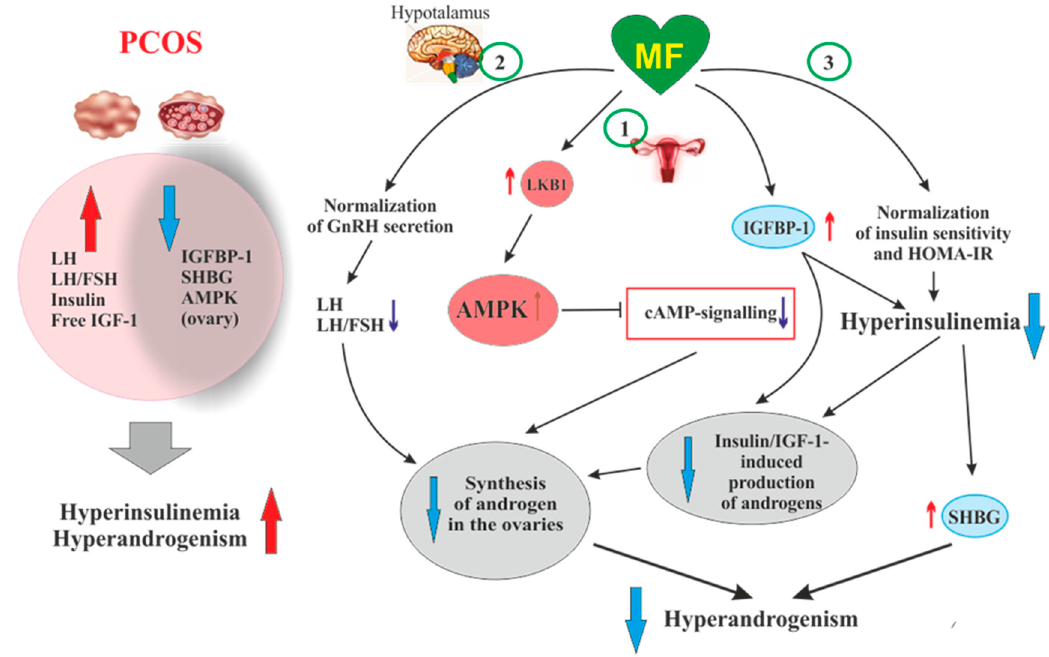
Figure 2. The pathways involved in the inhibitory effect of metformin on hyperandrogenism in PCOS. Hyperinsulinemia and HA are among the key pathogenetic factors in the development of PCOS, which is why, their attenuation by MF is the most important mechanism for improving effect of this drug on ovarian function in PCOS women. In PCOS, MF-induced increase in insulin sensitivity leads to a decrease in the HOMA-IR and a weakening of compensatory hyperinsulinemia. Another mechanism for lowering insulin levels may be an increase in the level of IGFBP-1, which specifically binds insulin and IGF-1. In PCOS, the expression of IGFBP-1 is generally reduced, and MF treatment may be one way to normalize it. A reduced hyperinsulinemia and an increase in IGFB-1 levels lead to a decrease in the stimulating effect of insulin and IGF-1 on the ovarian steroidogenesis and a weakening of HA. Hyperinsulinemia leads to a decrease in the production of SHBG, which provokes HA in PCOS. MF-induced reduction of hyperinsulinemia leads to the normalization of the SHBG levels, thereby preventing excess androgen levels in the blood. By improving the functionality of the hypothalamic signaling network responsible for the pulsatile secretion of GnRH, treatment with MF leads to the normalization of blood LH levels and the LH/FSH ratio, both of which are increased in PCOS. A decrease in blood LH levels results in a weakening of gonadotropin-induced androgen production by the ovaries. A direct regulatory effect of MF on ovarian steroidogenesis was also established. By inhibiting the mitochondrial ETC complex I, stimulating the LKB1 activity and, as a result, increasing the AMPK activity, MF reduces the synthesis of androstenedione in the ovarian cells and prevents HA. It can be assumed that the prevalence of some mechanisms of the inhibitory effect of MF on HA is due to the characteristic features of PCOS pathogenesis and the metabolic and hormonal status of the ovaries. Details and bibliographic references are presented in the Section 3.4. Abbreviations: AMPK, AMP-activated protein kinase; FSH, follicle-stimulating hormone; HA, hyperandrogenism; HOMA-IR, homeostasis model assessment of insulin resistance; IGF-1, insulin-like growth